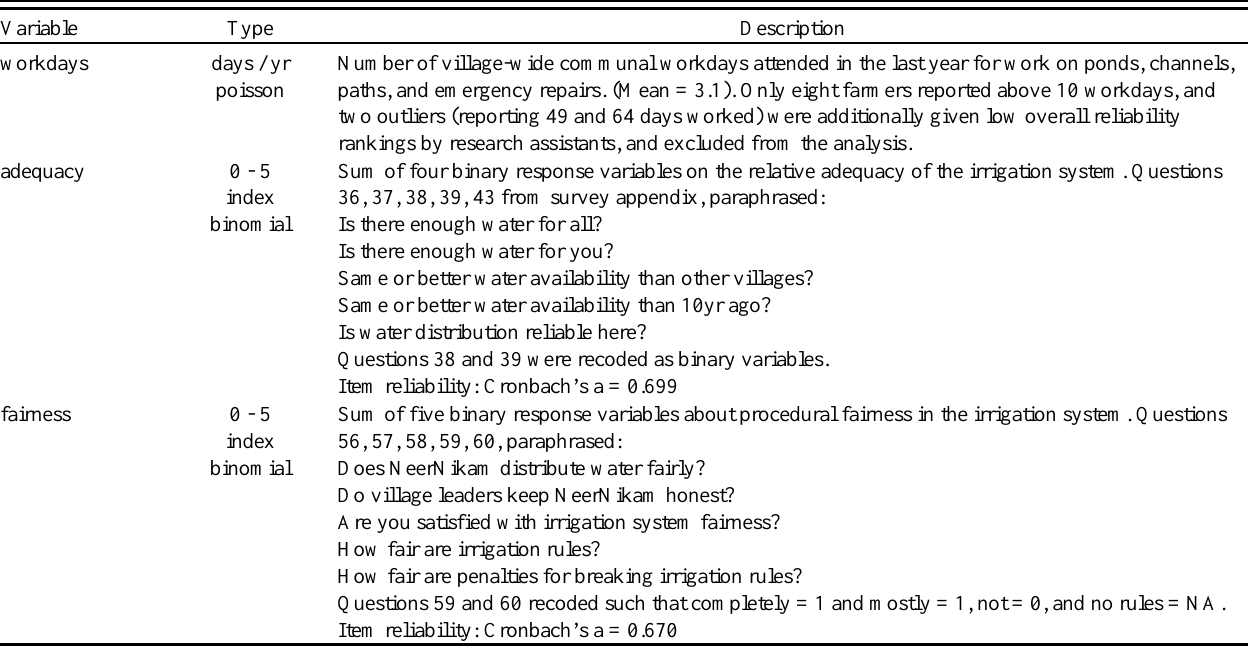
Table 2. Response variable descriptions. See appendix for response variable correlations calculated using restricted maximum likelihood. Note: a NeerNikam is responsible for maintaining the irrigation channels, overseeing water distribution, and quelling conflict between farmers.